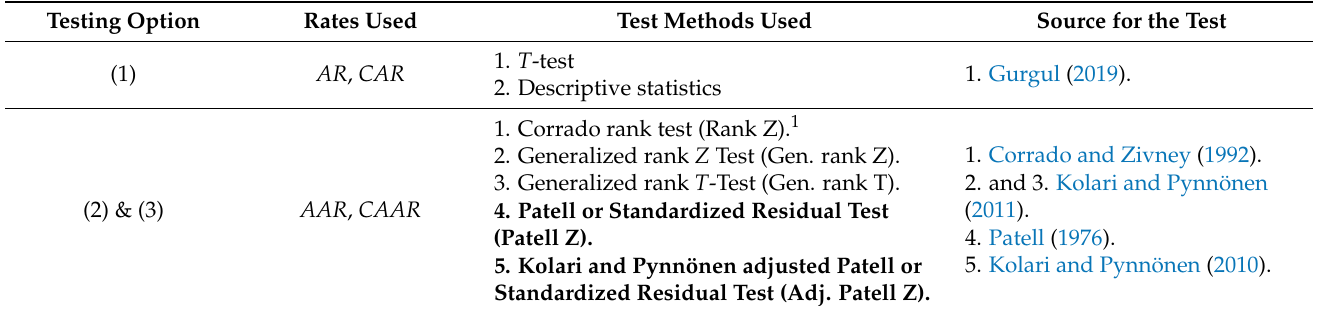
Table 4. The tools used depending on the test